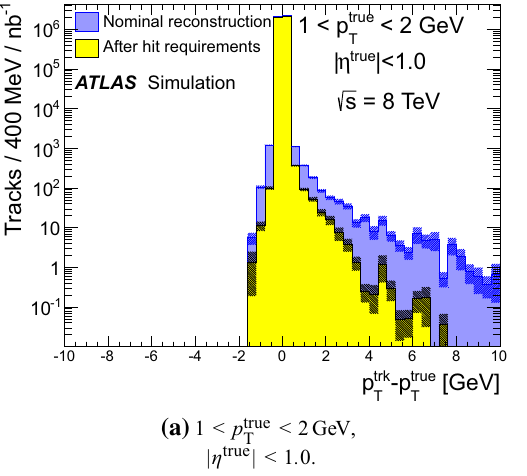
ciency as a function of p T in three | η | bins. A simulated dijet sample is used, with similar pile-up to that in the 2012 data, and for which < 1000GeV. The statistical uncertainties in the number of 20 < p lead T MC simulated events are shown in a darker shading